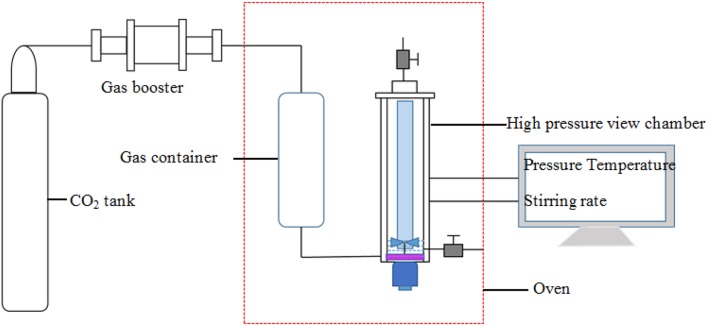
Schematic diagram of the apparatus to evaluate foam stability.